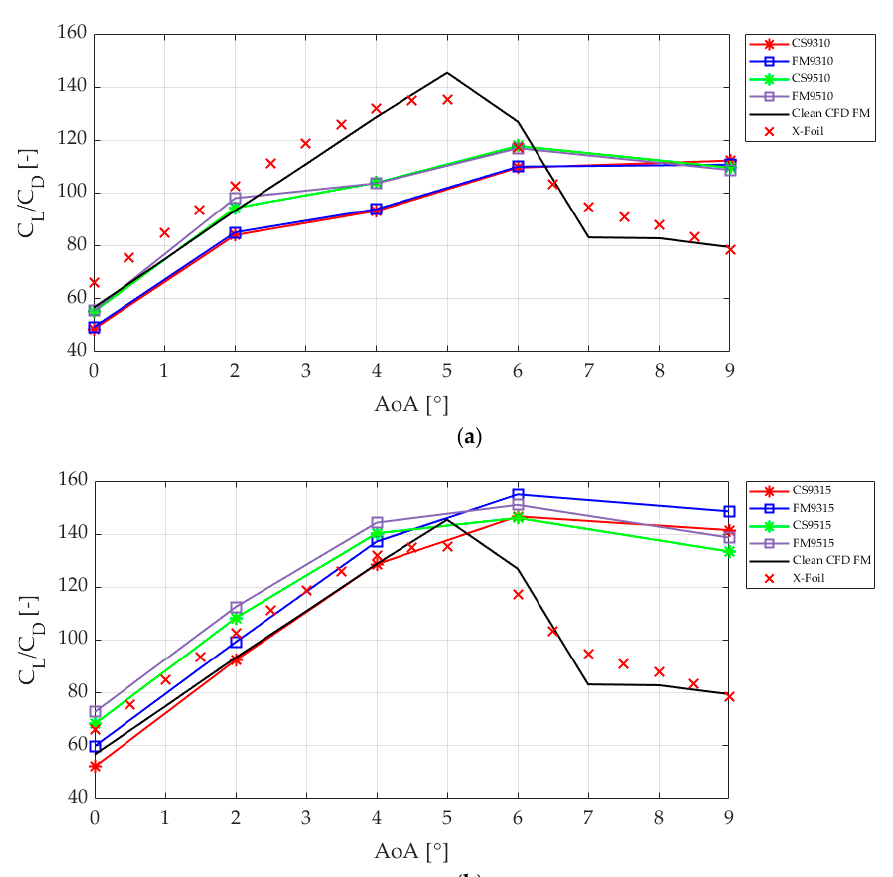
Figure 4: y = 1.0% of c (a), y = 1.5% of c (b) and y = 2.0% of c